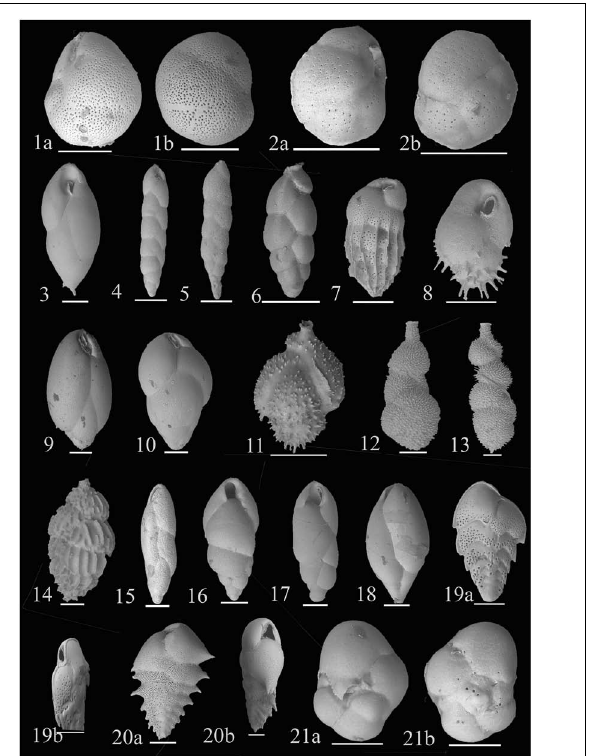
FIGURE 3 | The dominant living benthic foraminifera (relative abundance ≥ 3% at atleast three stations) in the west-central Bay of Bengal (1) Hormosinella distans (Brady, 1881); (2–4) Hormosinella guttifera (Brady, 1881); (5) Reophax scottii (Chaster, 1892); (6) Ammobaculites agglutinans (d’Orbigny 1846); (7) Ammoglobigerina globigeriniformis (Parker and Jones, 1865); (8) Trochamminopsis quadriloba (Hoglund, 1947); (a) Ventral view (b) Dorsal view; (9) Eggerella propinqua (Brady, 1884); (10) Textularia oceanica Cushman, 1932; (11) Spiroloculina convexa Said, 1949, (a–c); (12) Quinqueloculina bicarinata (d’Orbigny, 1878); (a) 4-chambered view (b) Apertural view (c) 3-chambered view; (13, 14) Bolivinellina earlandi (Parr, 1950); (15) Bolivinellina lucidopunctata (Conato, 1964); (16) Bolivinellina pacifica (Cushman and McCulloch, 1942); (17) Bolivinellina translucens (Phleger and Parker, 1951); (18, 19) Brizalina dilatata (Reuss, 1850); (20) Bolivina mekranensis (Haque, 1970); (21) Brizalina spathulata (Williamson, 1858); (22) Latibolivina lepida ; (23) Latibolivina persiensis (Lutze, 1974); (24) Cassidulina carinata Silvestri, 1896; (a) Ventral view showing aperture (b) Dorsal view; (25) Cassidulina laevigata (d’Orbigny, 1826), (a) Dorsal view, (b) Ventral view showing aperture. Scale bar is 100 µ m.